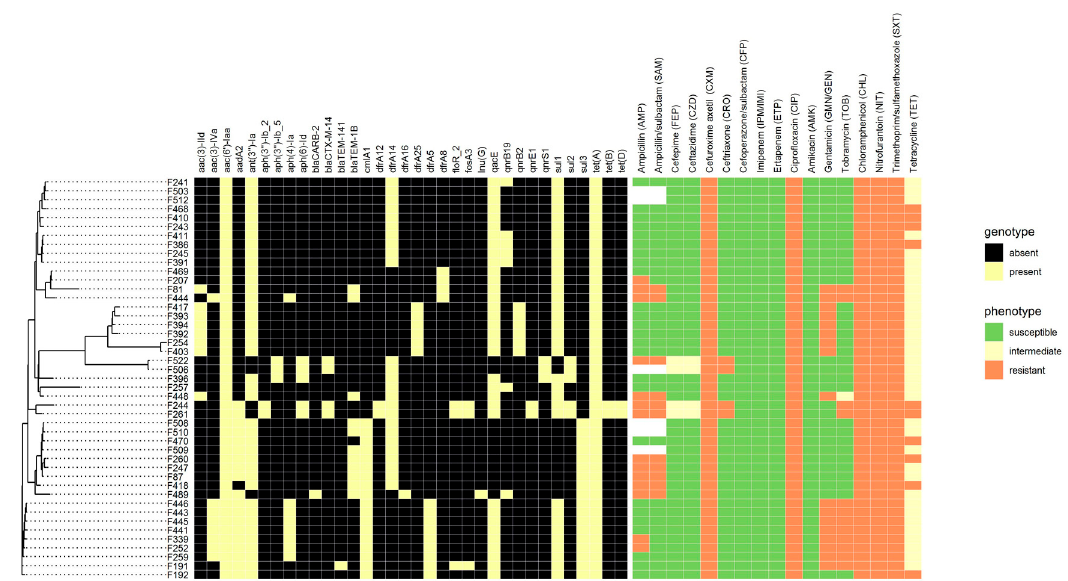
Figure 1. Phenotypic and genotypic antibiotic resistance profiles of the S. Infantis isolates studied. The tree shown on the left was built using ad hoc core genomes calculated by roary with the total number of core genes being 4371. White color means missing results for particular antibiotics.